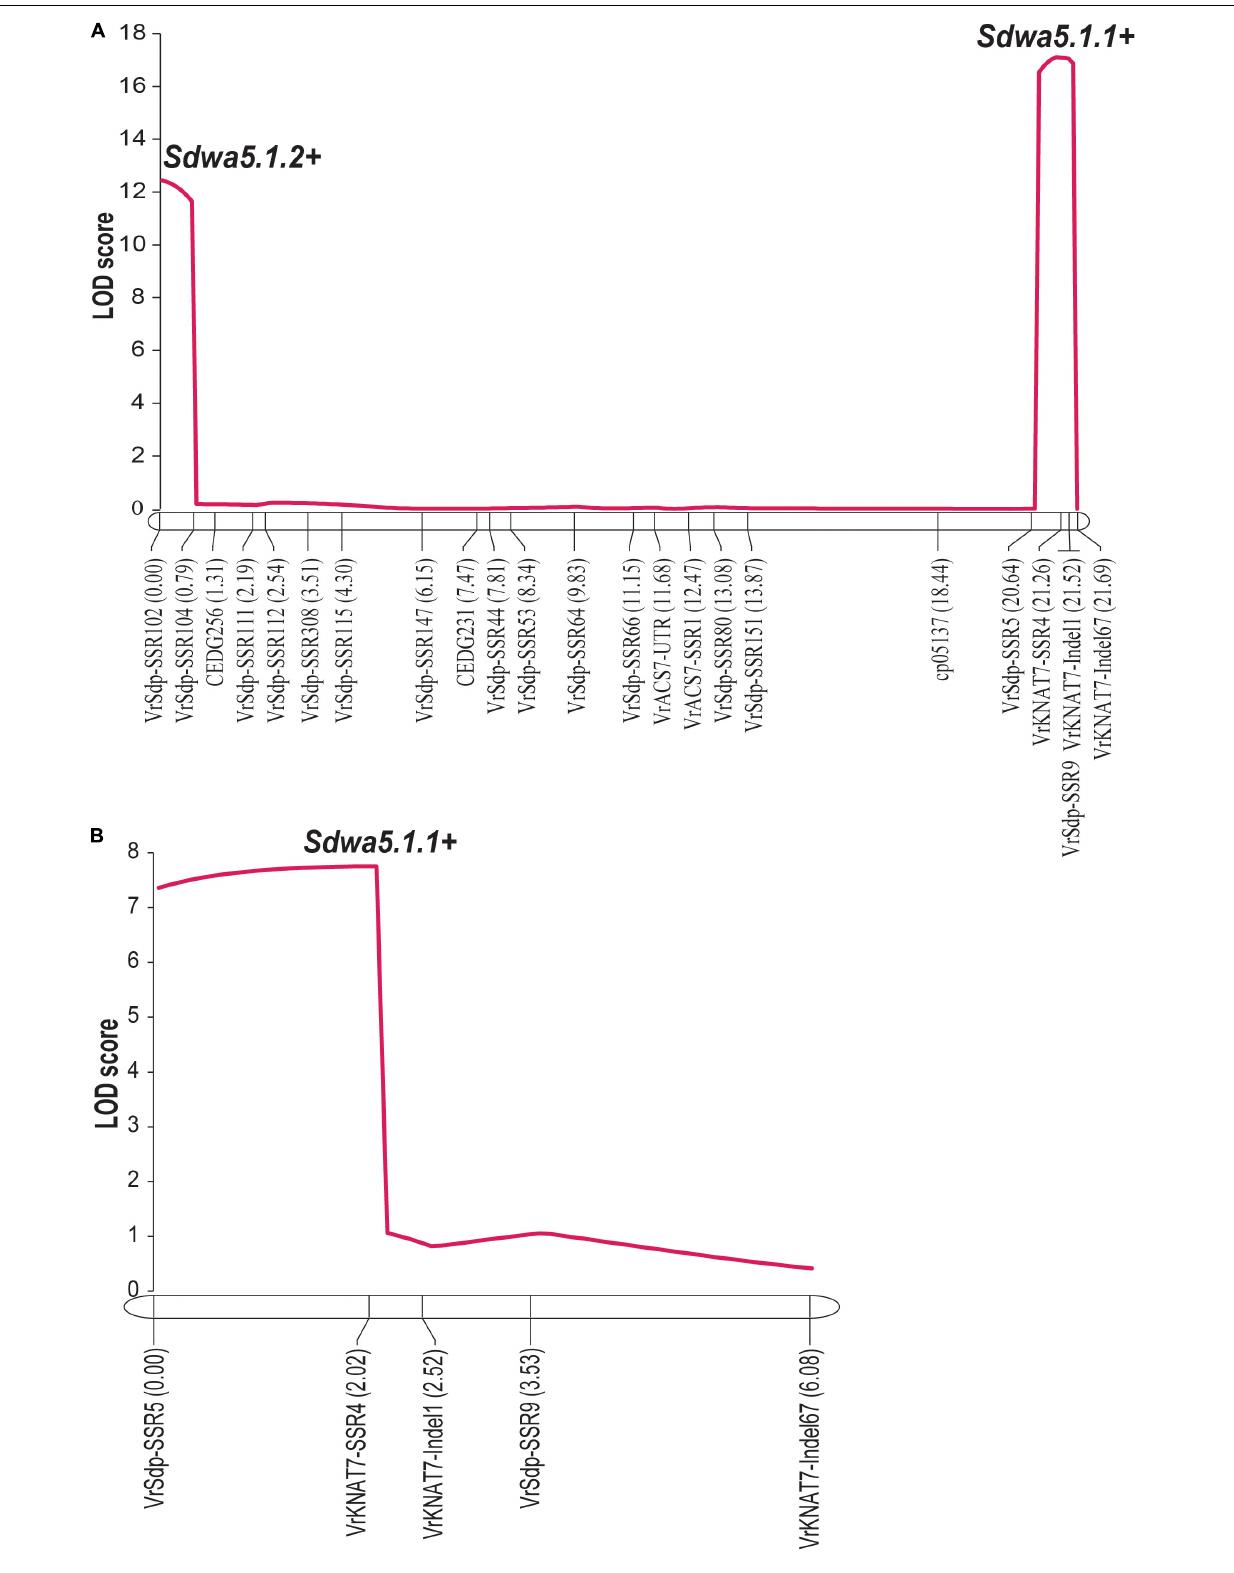
FIGURE 4 | Logarithm of the odd (LOD) graphs of quantitative trait loci (QTLs) for seed dormancy detected on linkage group 1 of F 2 population of 573 individuals (A) and F 2 : 3 population of 100 individuals (B) derived from the cross between KPS2 and ACC41. Dotted line parallel to x -axis represents LOD threshold for the QTLs.